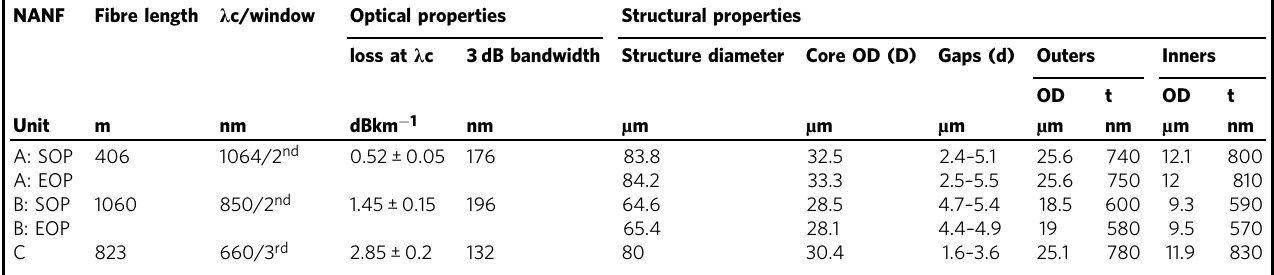
Table 1 Key optical and physical parameters of the fabricated NANFs including fi bre length, loss at centre wavelength ( λ c ), diameter of the microstructure, core diameter (D), inter-tube gaps (d), silica tube thickness (t) and outer diameter (OD). NANF Fibre length λ